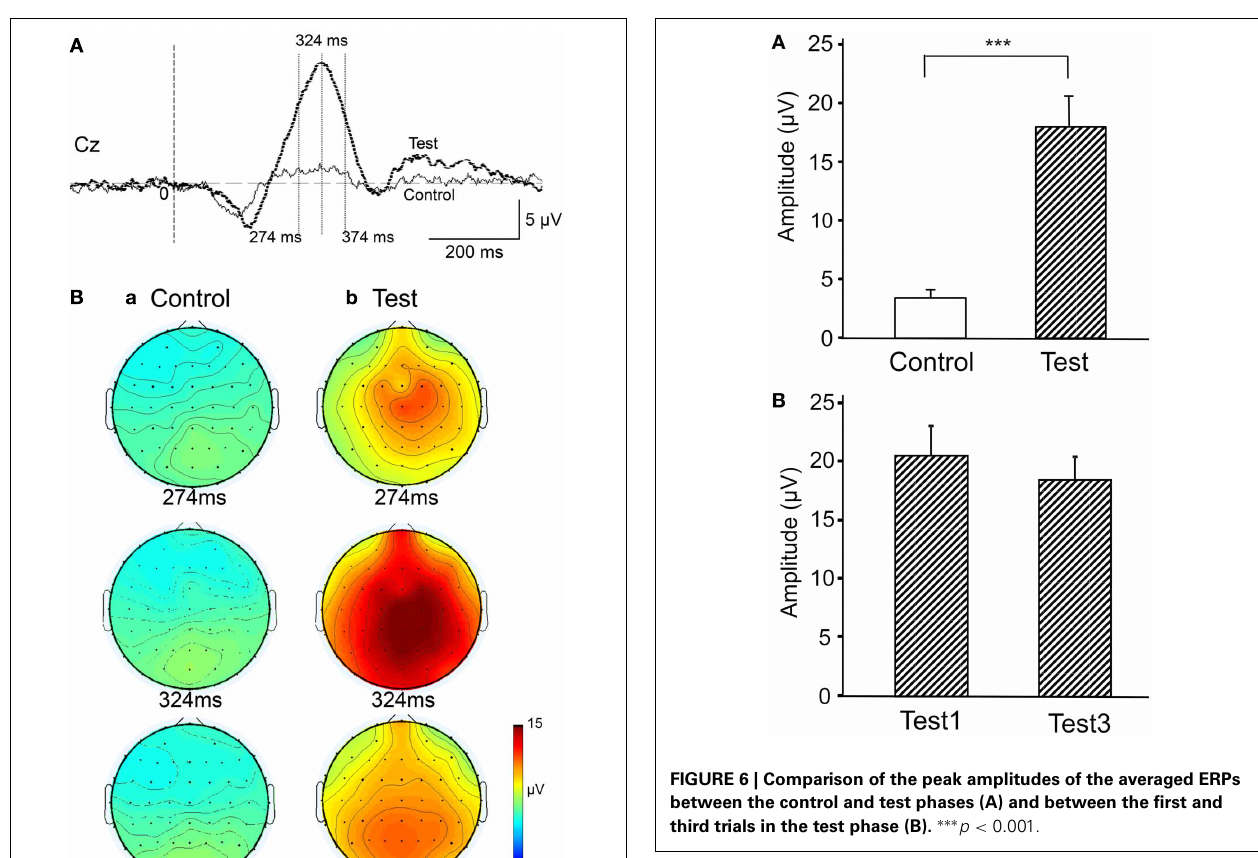
latencies from 314 to 324 and 354 to 364 ms, current source den-